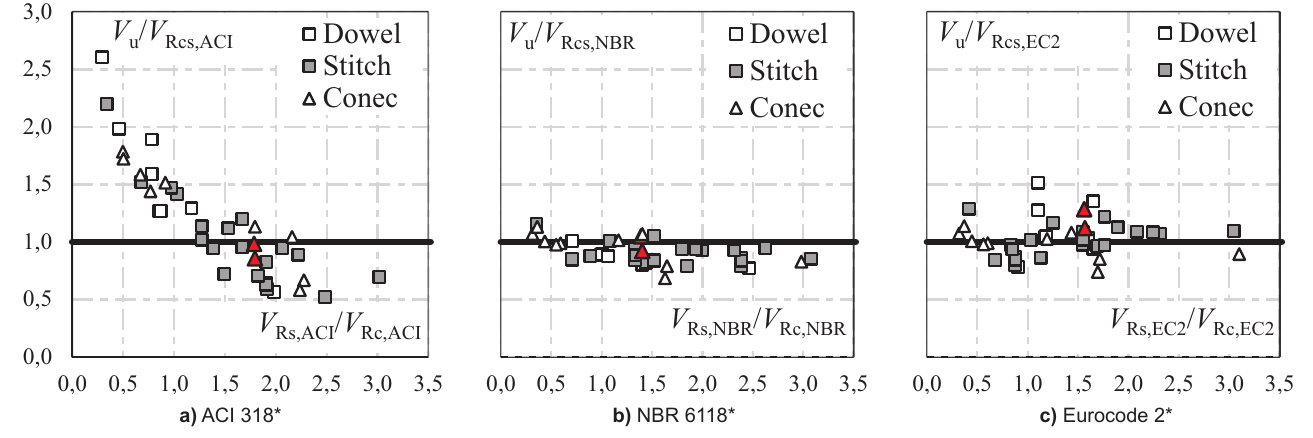
Figura 13 Influência do aumento da taxa de armadura de cisalhamento nas previsões de resistência para lajes rompendo dentro da região reforçada Nas Figuras 12, 13 e 14, os resultados de ensaios onde os autores informam que a ruptura ocorreu dentro da região das armaduras de reforço são utilizados para discutir tanto o desempenho das di- ferentes técnicas de reforço, quanto a resposta da metodologia de cálculo apresentada na Tabela 1. Os triângulos vermelhos nestas figuras indicam resultados de ensaios com conectores pós-instala - dos de aço com ancoragem mecânica nas duas extremidades (ver Carvalho [25]). A Figura 12 apresenta a influência do acréscimo de reforço, medida pela razão entre a força estimada para as arma-